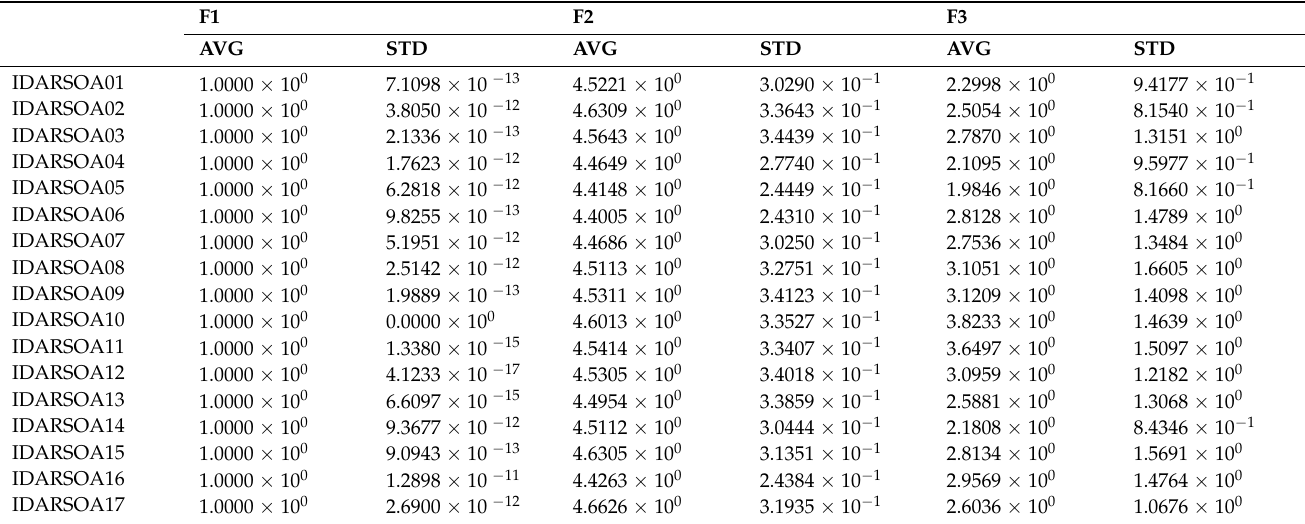
Table 3. Comparison of parameters